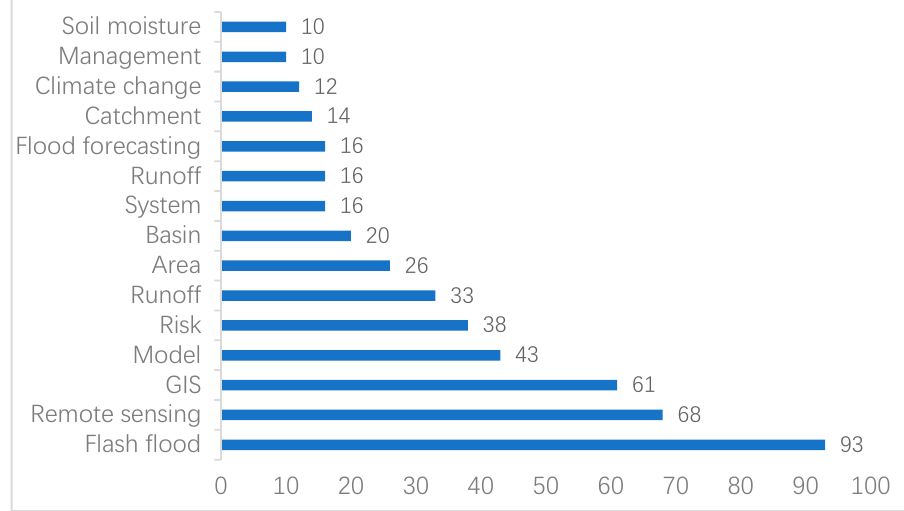
Figure 3. Keywords with more than 10 occurrences in 248 articles.